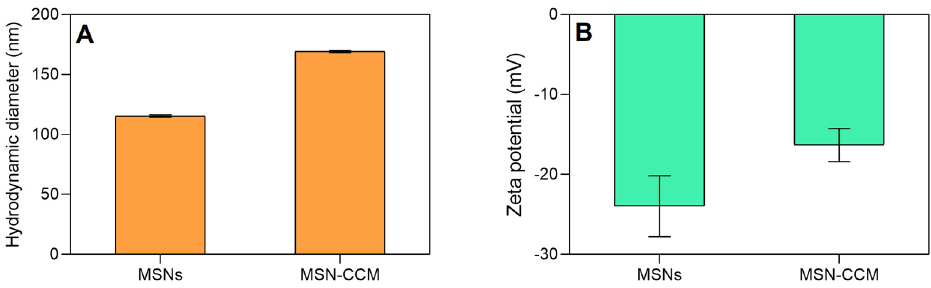
Figure 2. ( A ) Hydrodynamic average diameter and ( B ) zeta potential of the MSNs and MSNs-CCM. The polydispersity index represents the particle size distribution. Values below 0.5 indicate a homogeneous size distribution and values greater than 0.5 indicate a heteroge- neous size distribution [59]. The polydispersity index increased from 0.26 ± 0.01 to 0.48 ± 0.01 after loading of CCM, indicating a moderate polydisperse profile of CCM-loaded